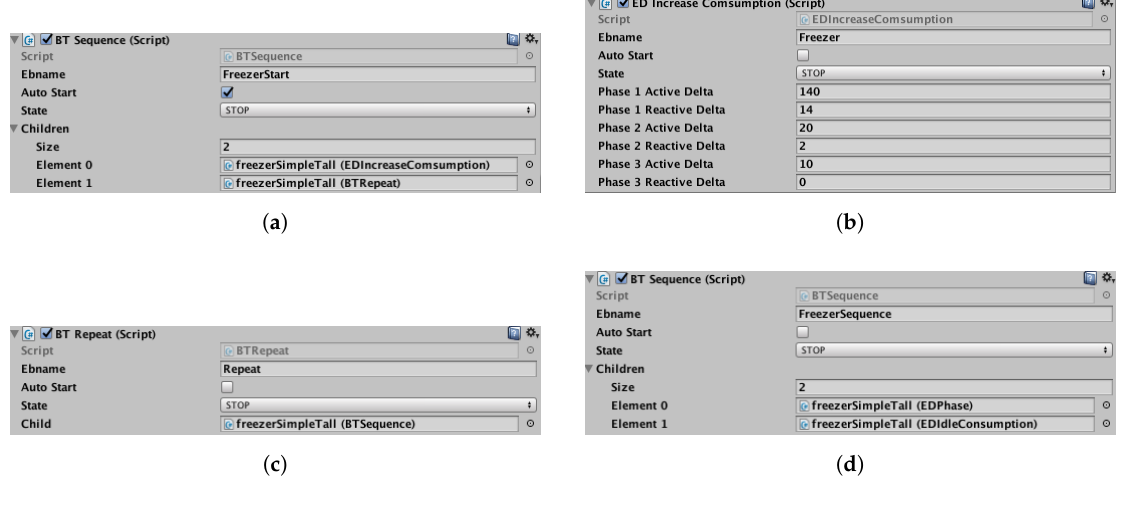
Figure 9. Screenshots of behavior tree edition in the Unity inspector. ( a ) Composite node; this element is the root of this tree; ( b ) The first son of the node in Figure 9a; this element increases the electricity consumption; ( c ) The second son of the node in Figure 9a and composite node “ repeat ”; ( d ) Son of node in Figure 9c; this composite node manages the cooling phase of our refrigerator and creates its electric